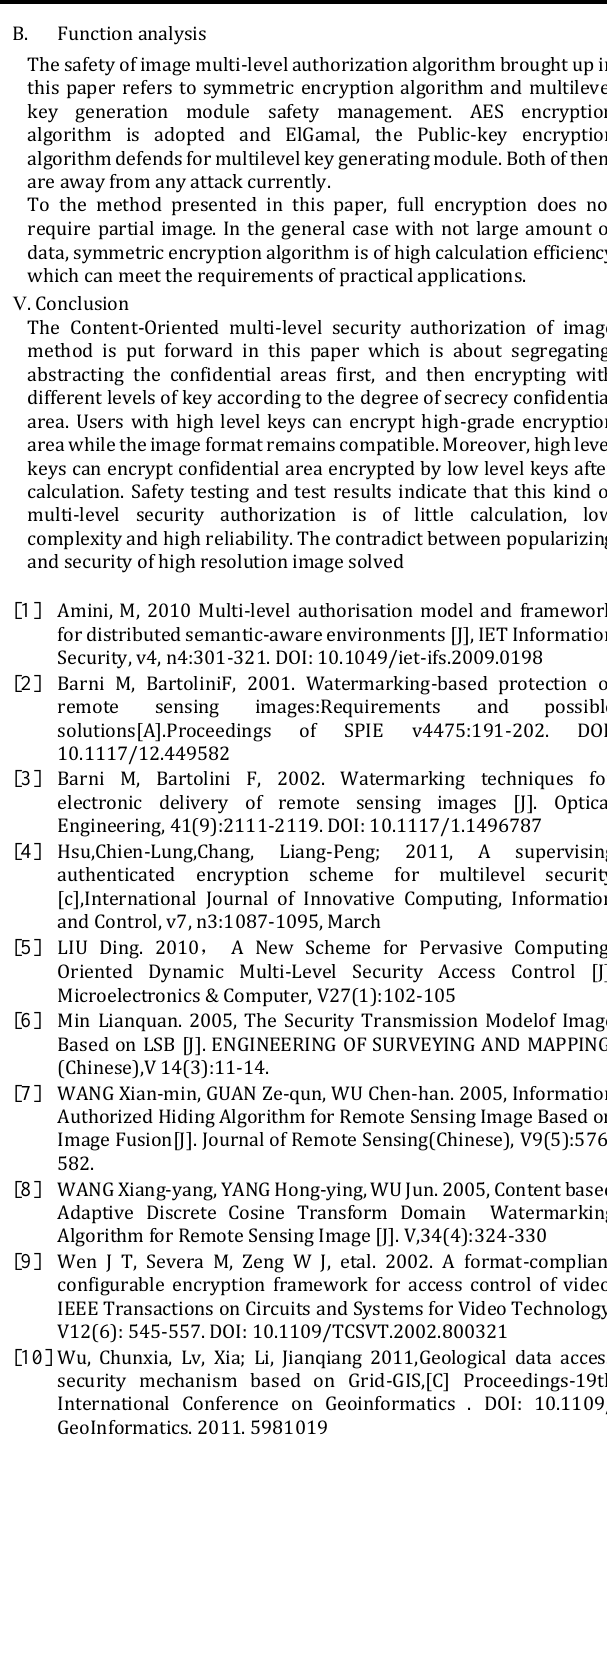
Figure 6. Security regions multi-level encryption based on the point, line and plane